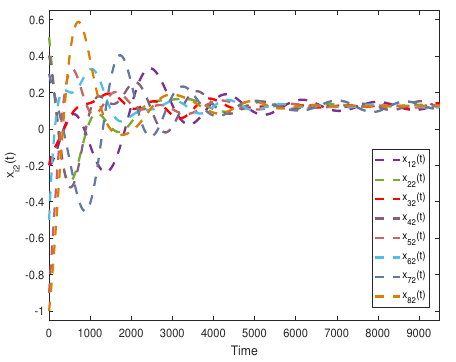
Figure 10. The states of x i 2 ( t ) .